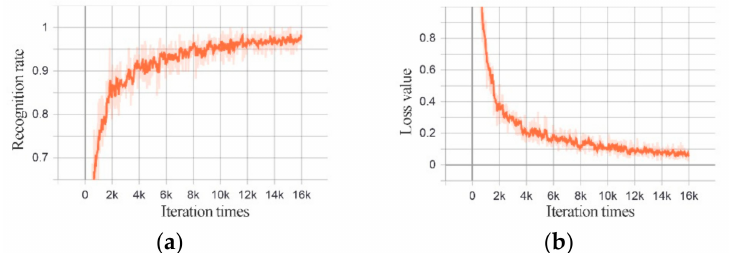
Figure 14. MFIJD model structure 1 training process: ( a ) The change of recognition rate of training set with the number of iterations. ( b ) The change of loss function with the number of iterations.